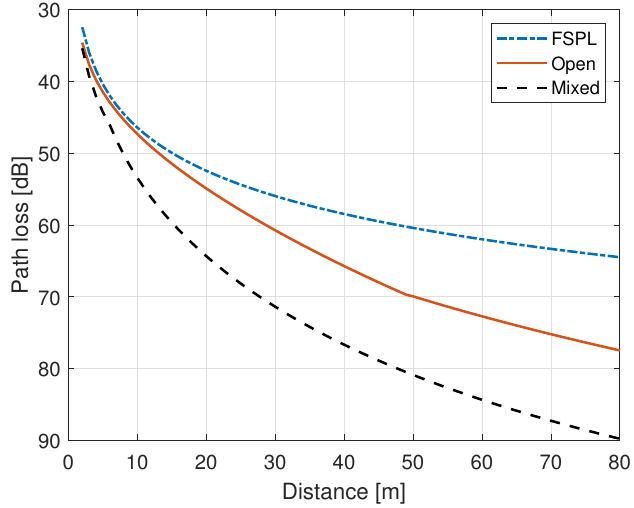
Figure 3. Path loss with FSPL and 3GPP InH model at